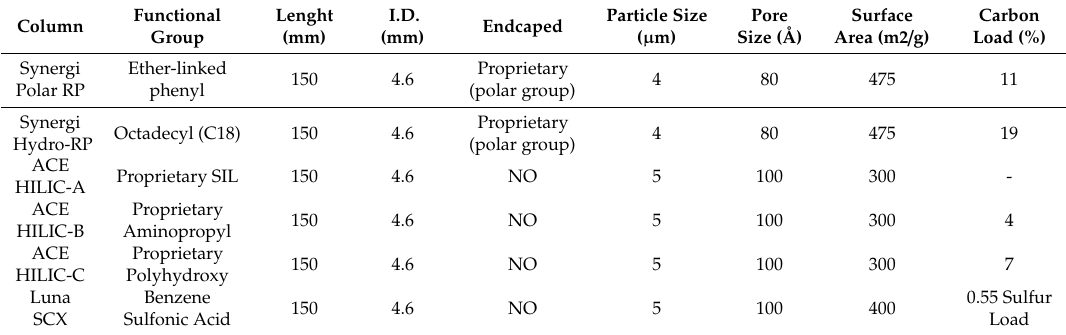
Table 6. List of tested columns and their physicochemical